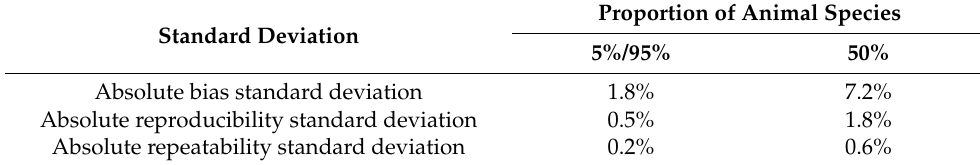
Table 5. Bias standard deviation, reproducibility standard deviation, and repeatability standard deviation (absolute, i.e., retransformed to proportions of animal species) depending on the proportion of animal